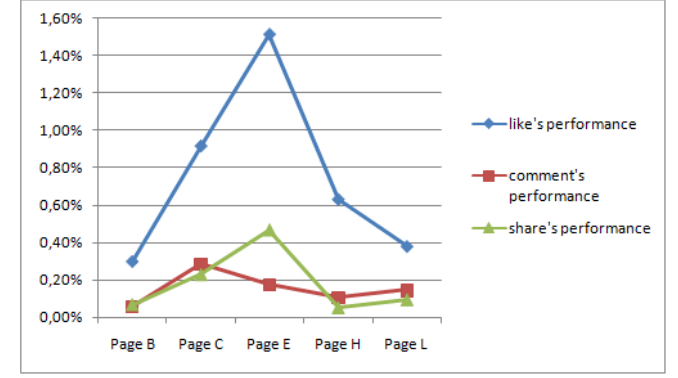
Fig. 3. Performance rate of interaction types over pages B, C, E, H, and